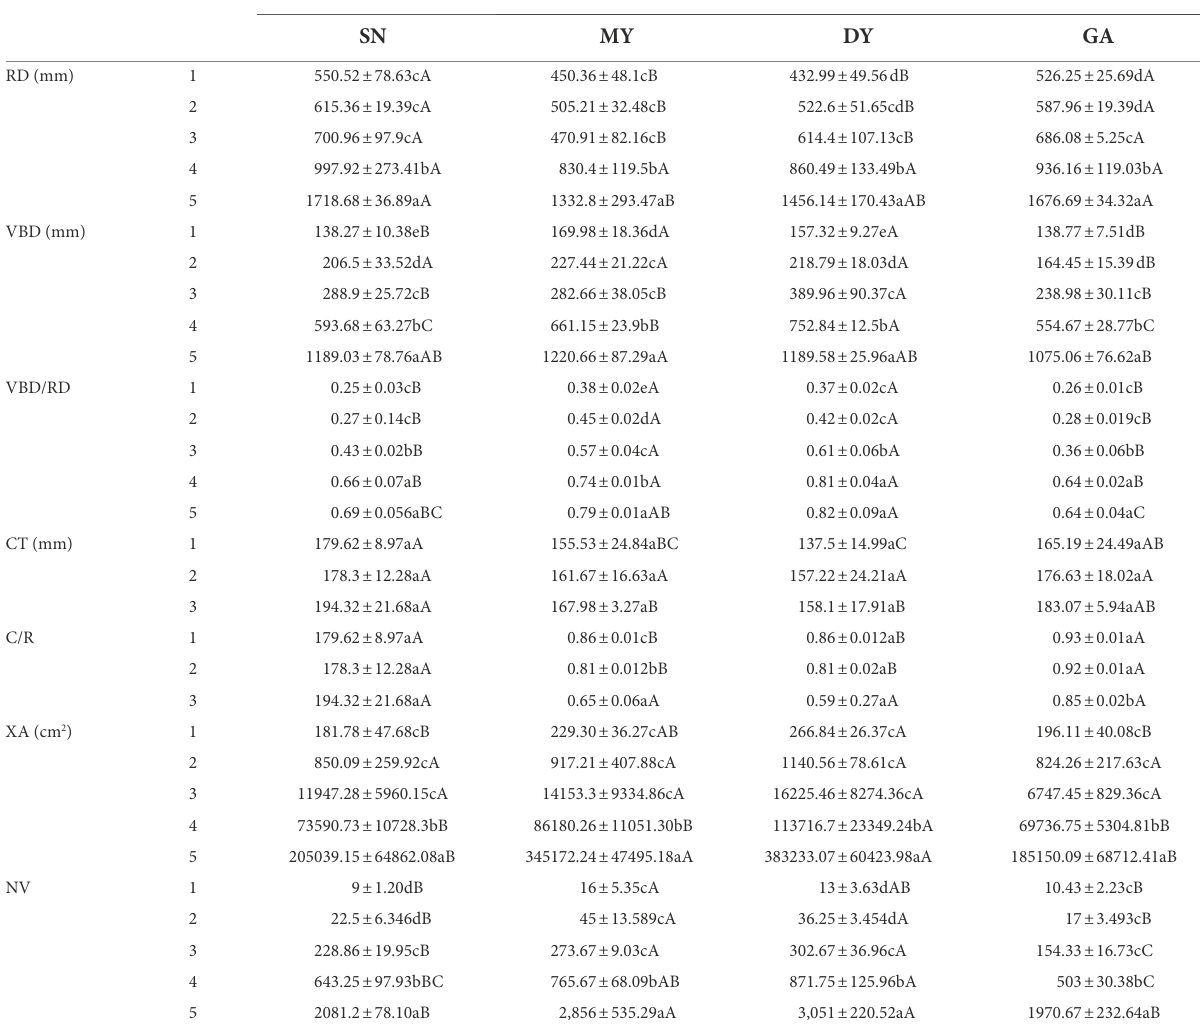
TABLE 3 Cupressus funebris anatomical structure of fine root in the first to fifth order roots among four test